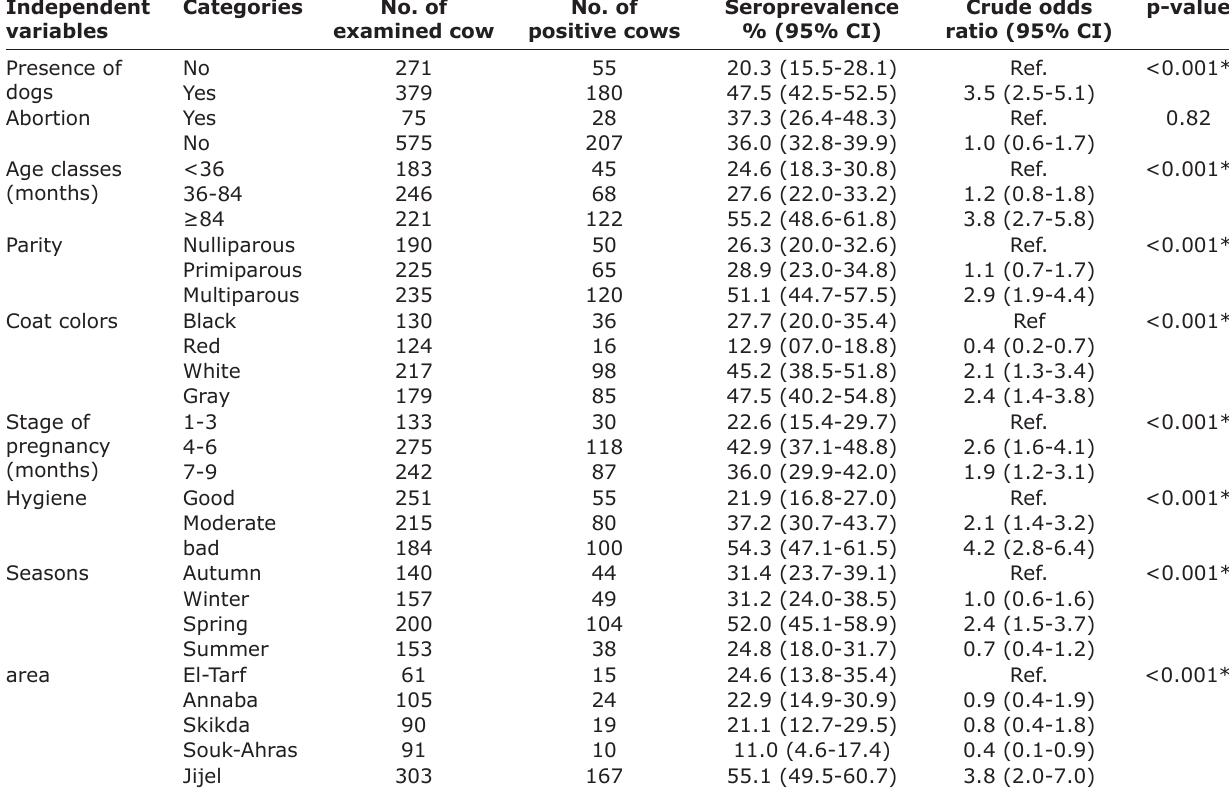
Table-1: Risk factors associated with Neospora caninum with univariable analysis among pregnant local cows. Independent